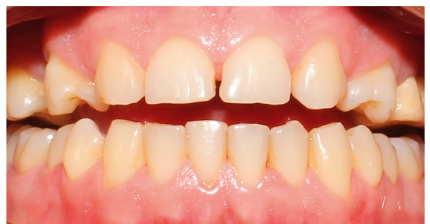
Figure 1: Preoperative view of the patient’s smile.